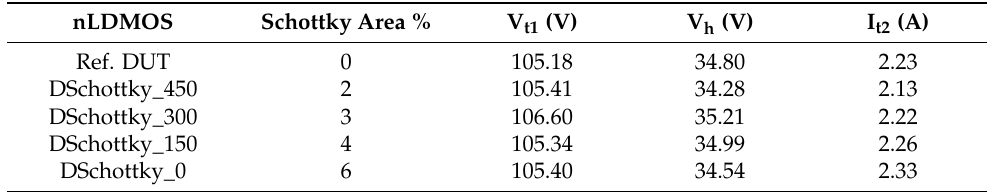
Figure 10. Secondary breakdown-current distribution chart of HV nLDMOSs with the drain electrode-embedded horizontal Schottky length modulation. Table 4. Snapback extracted parameters of HV nLDMOSs with the drain electrode-embedded horizontal Schottky length modulation.